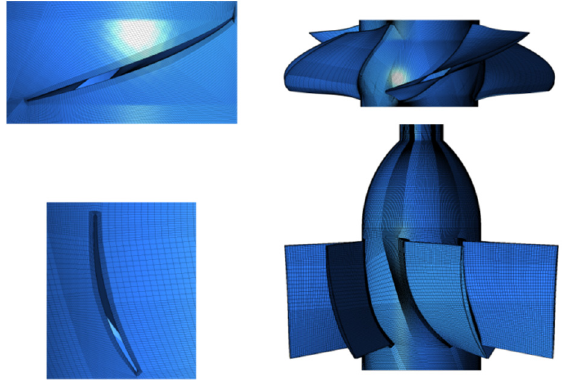
Figure 2. Mesh of the axial flow pump.